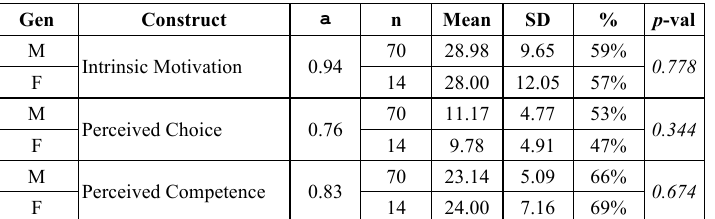
Table 2. Results from Post-survey of students -